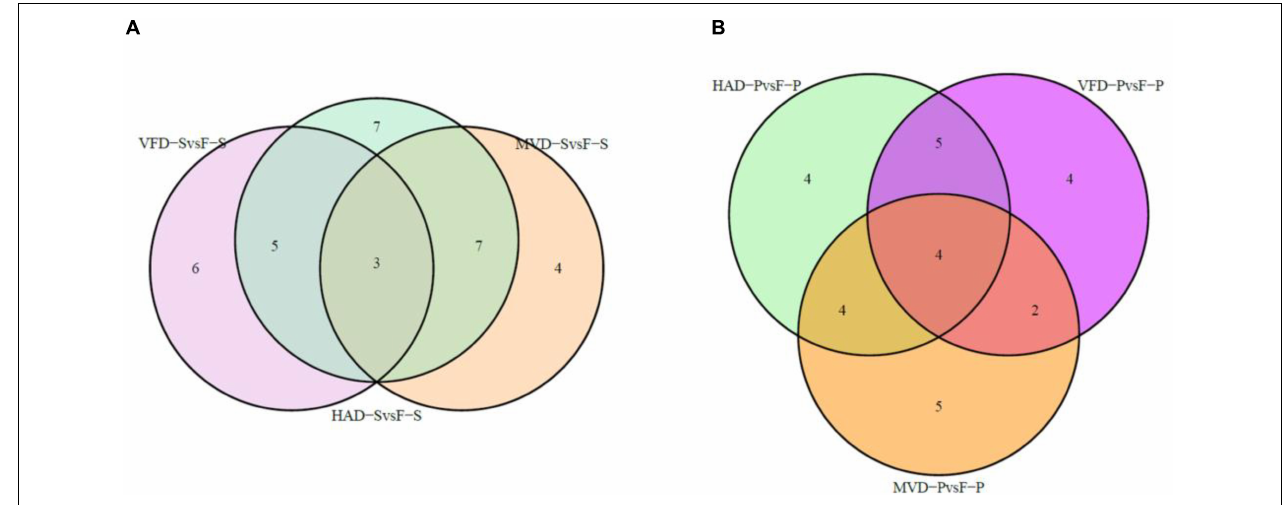
FIGURE 5 | Venn diagrams of overlapping and unique non-volatile taste metabolites screened for differential expression. In panels (A,B) are the comparisons in stipe and pileus, respectively.